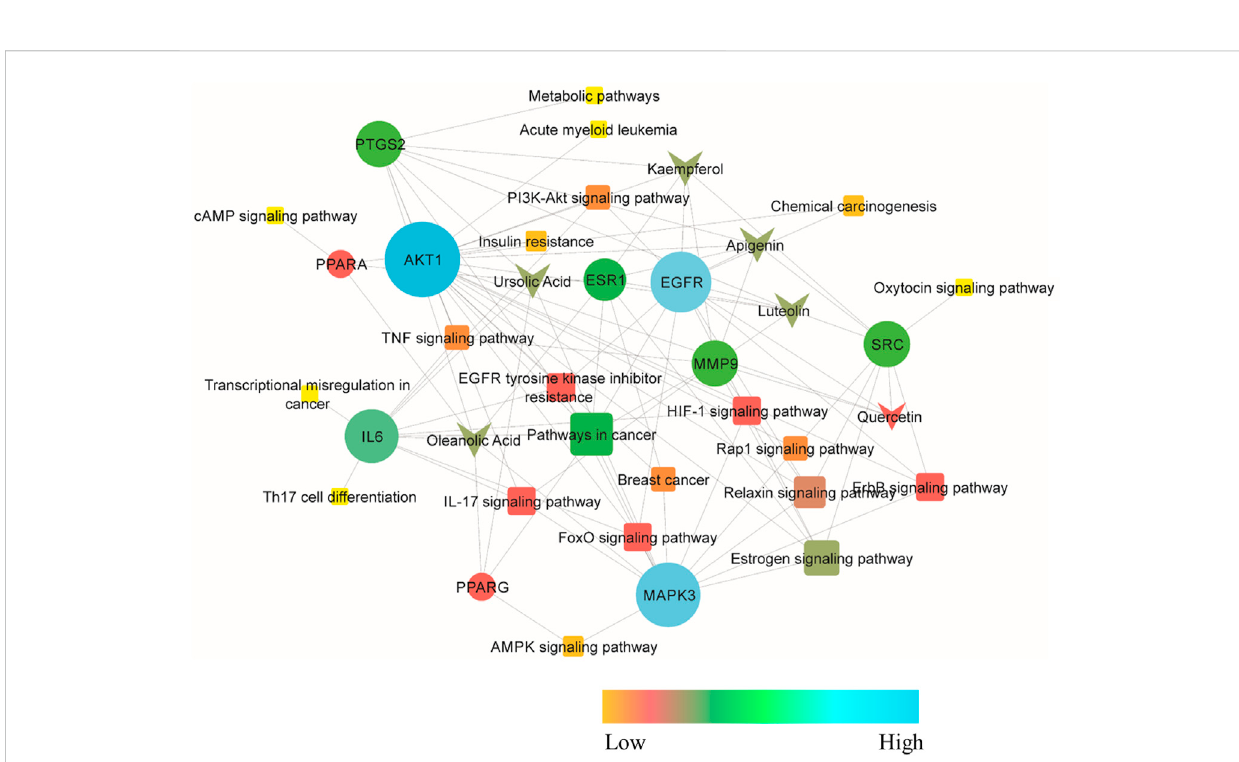
FIGURE 3 Compound – target – pathway network. The core protein is shown as a circle, active compounds as arrows, and pathways in which the core targets were involved as squares. Additionally, the nodes are colored with a gradient to indicate their degree of connectivity.